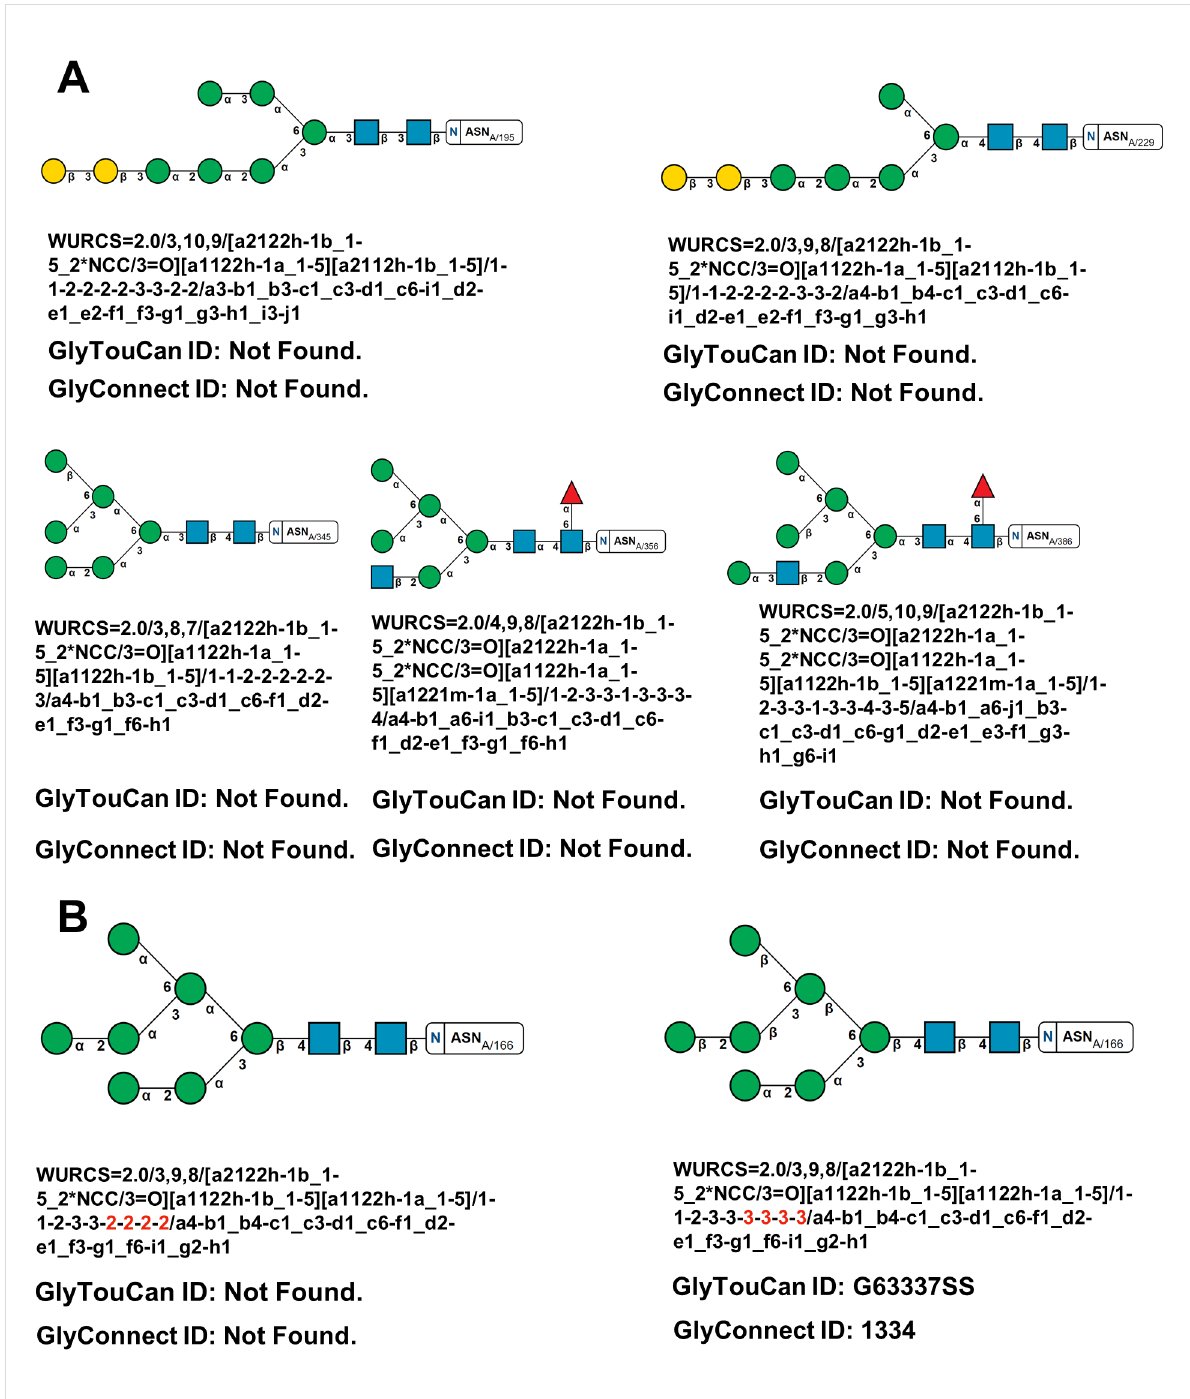
Figure 3: N-Linked glycans in Epstein Barr virus major envelope glycoprotein (PDB entry: 2H6O [66]). A) A selection of the glycan chains that failed to return database IDs with their WURCS sequences extracted from the Privateer CCP4i2 report. B) Glycan chain (right) for which a GlyTouCan and GlyConnect ID have successfully been matched with the modelling errors present in the model. After manual fixing (left), the WURCS sequence for the glycan failed to return database IDs. Highlighting in red depicts the locations in WURCS notation where both glycans differ.